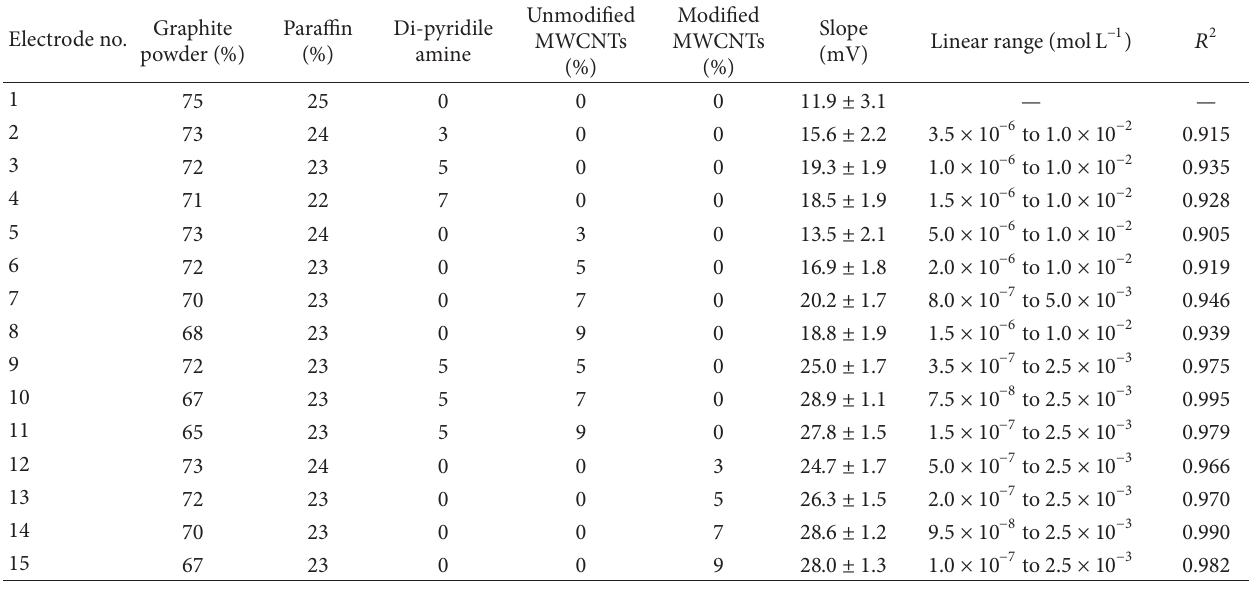
T 1: Optimization of the electrode composition.